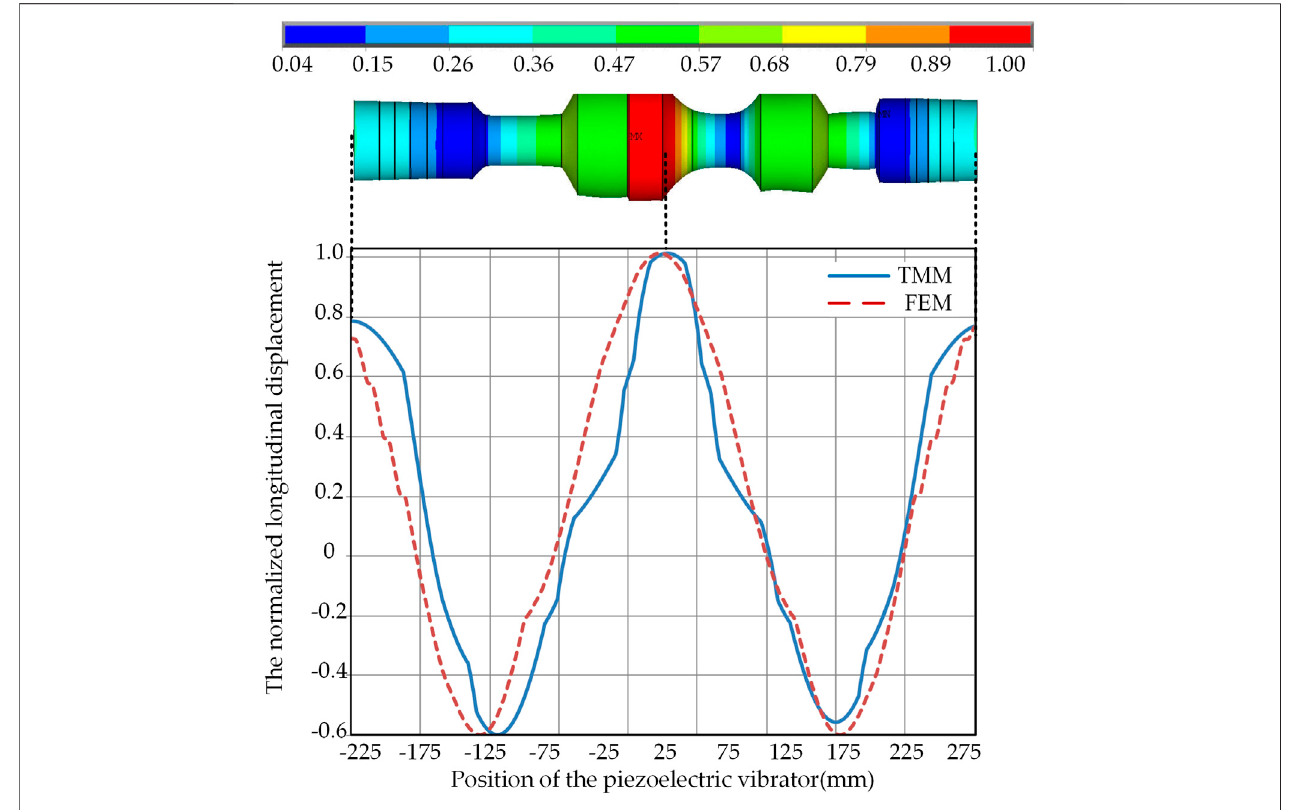
FIGURE 12 | Modal analysis of piezoelectric